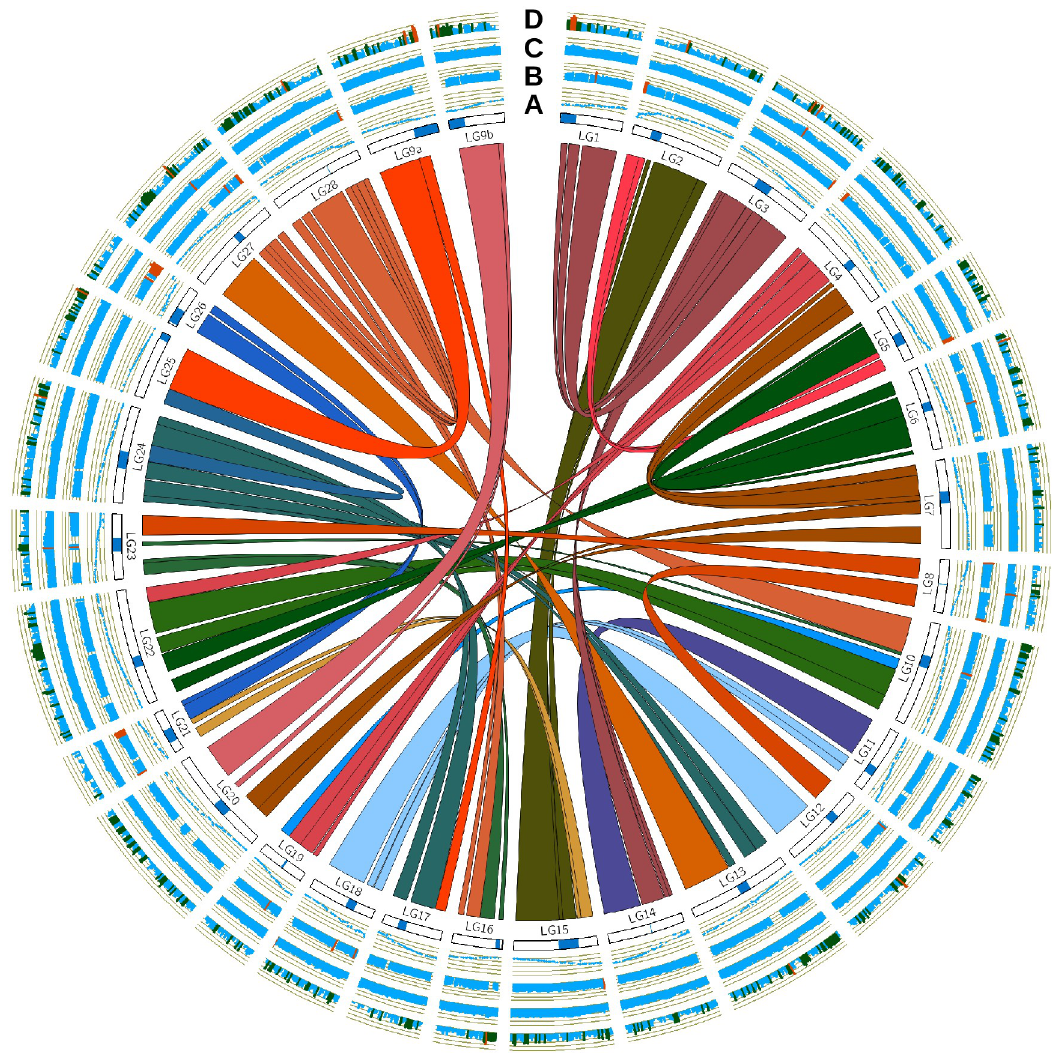
Fig 1. Sockeye salmon circos plot. Interior links were generated by SyMap between homeologous regions (only blocks larger than 2 Mbp are shown). Circle A) Larson et al. (2016) [62] female genetic map markers plotted against the corresponding chromosomal positions. Centromeres from Larson et al. (2016) are shown in blue below the genetic map. Circle B) The percent identity between homeologous regions in 1 Mbp intervals and weighted by alignment length (scale: 75–100%). Percent identities above 90% are highlighted with orange. Circle C) The fraction of repetitive sequences in 1 Mbp windows ranging from zero to one (fractions above 0.65 are shown in orange). Circle D) Log-transformed counts of variants with LD (r 2 � 0.5) to other markers � 100 kbp away in 1 Mbp windows. Window counts between 100–999 are green, while those with counts greater than 999 are